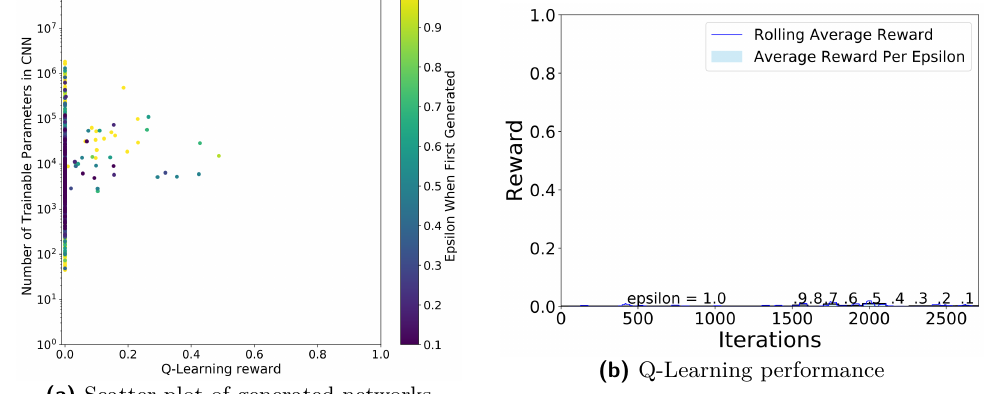
Figure 19: An overview of both the number of trainable parameters, reward, ε , and Q-Learning performance when R = t 0